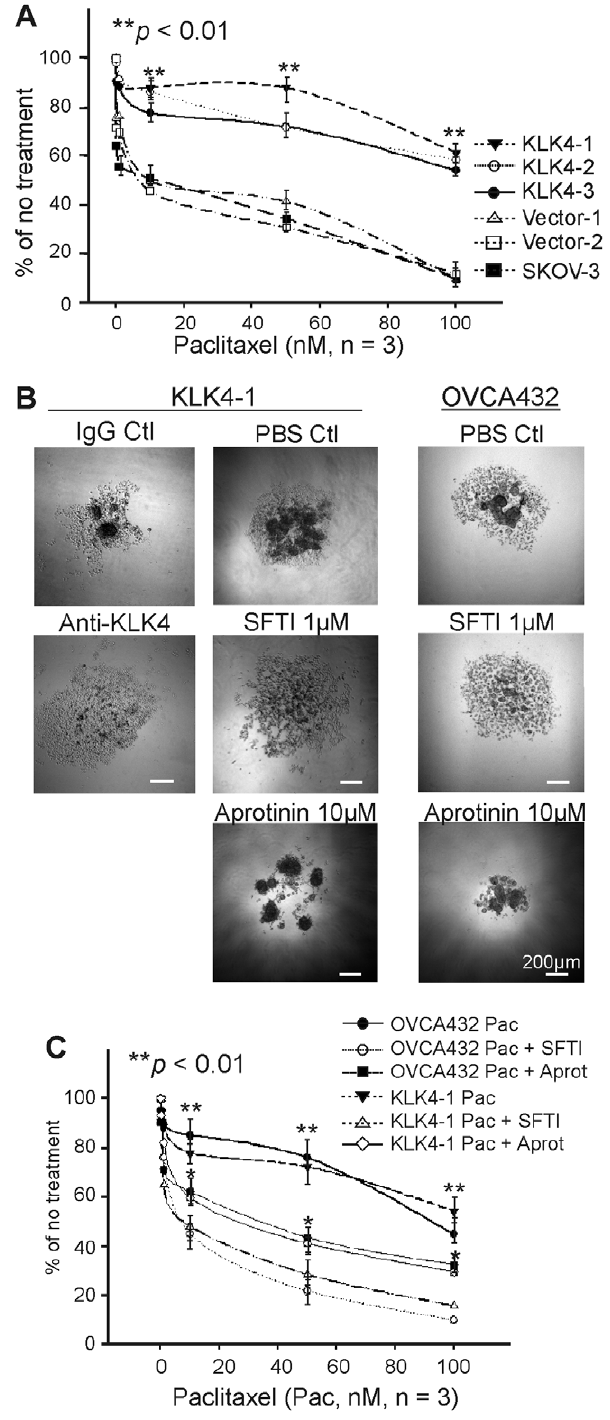
Figure 4. Inhibition of KLK4 increased paclitaxel sensitivity. WST-1 assay shows cell survival of KLK4-1, KLK4-2, KLK4-3, Vec-1, Vec-2 clones and native SKOV-3 MCAs after paclitaxel ( A ) treatment in 3D- suspension. B. Left panel, representative images of KLK4-1 MCAs on day 4 with mouse IgG and a functional KLK4 blocking antibody, PBS as a control and KLK4 selective inhibitor SFTI-FCQR (SFTI) as indicated. Right panel, representative images of OVCA432 MCAs on day 4 with PBS as a control and KLK4 selective inhibitor SFTI-FCQR (SFTI) or aprotinin as indicated. Scale bars, 200 m m. C. Cell survival determined by WST-1 assay after treatment with paclitaxel (Pac) on 3D-suspension